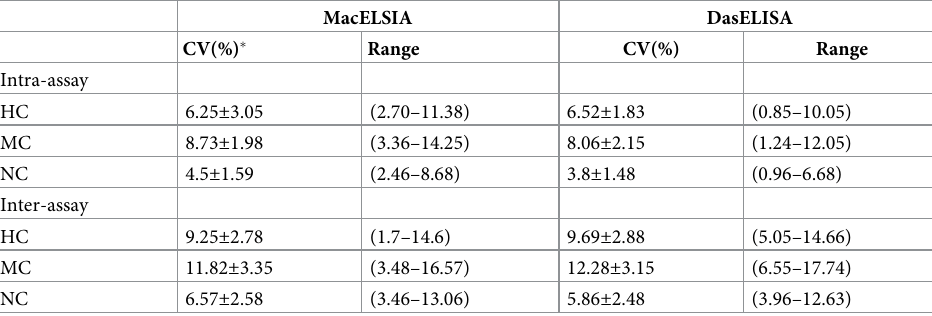
Table 1. Repeatability estimates for indirect IgG ELISA and